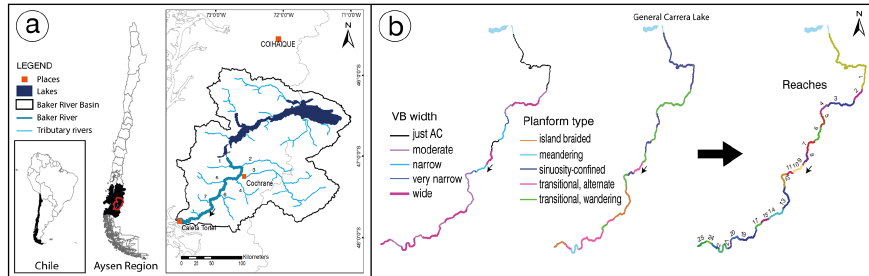
Figure 7. ( a ) the basin of the Baker River between Argentina and Chile. Numbers on the right identify tributaries; ( b ) Baker case study: Definition of reaches for a stretch of the Baker River (Chile) obtained with the method proposed here. From the left, segmentation of the VB width; planform type, and the reaches obtained (scale: 1:1,000,000 approx.).